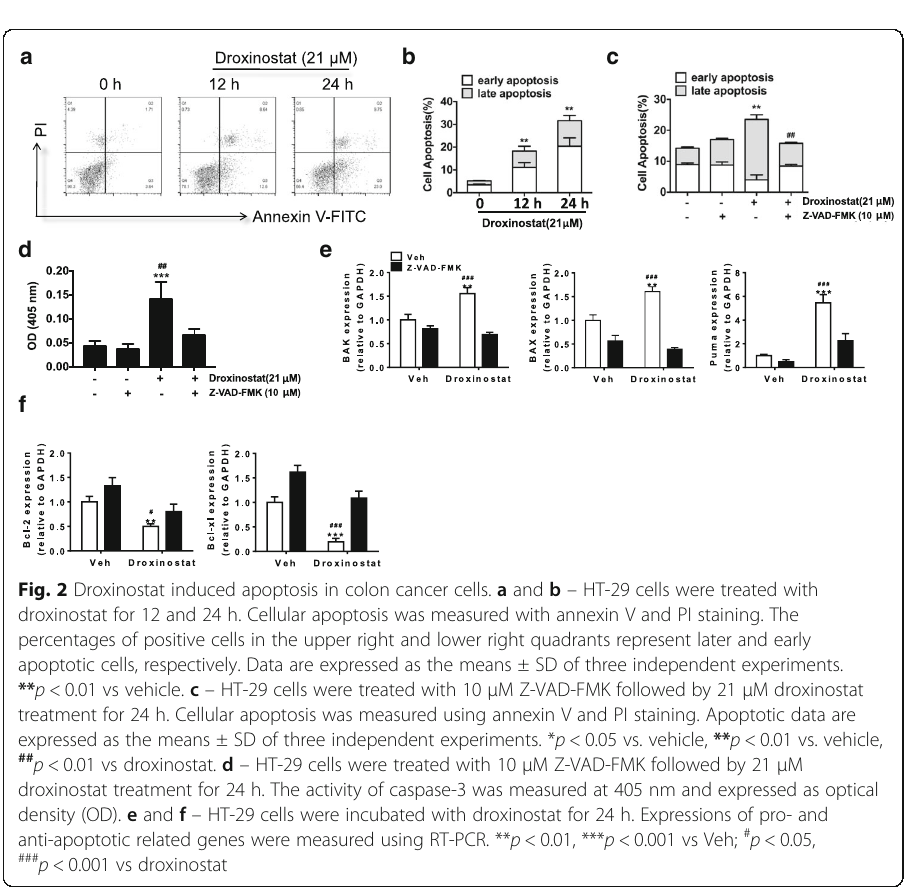
indicated that droxinostat inhibits the growth of cancer cells, and that this is at least in part due to induction of cellular apoptosis.